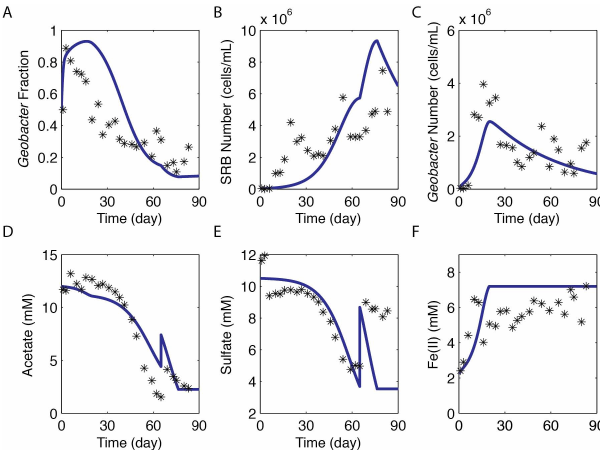
Fig. 2. In silico predictions of trends in the fraction of Geobacter in the community (A) , number of SRB (B) , number of Geobacter (C) , acetate concentration (D) , sulfate concentration (E) , and Fe(II) con- centration (F) . Lines are the in silico predictions; * are the exper- imental values. The experimental Fe(II) values are calculated by multiplying the total iron concentration of 7.5mM with the experi- mentally measured Fe(II) percentage in total Fe(II) from Fig.